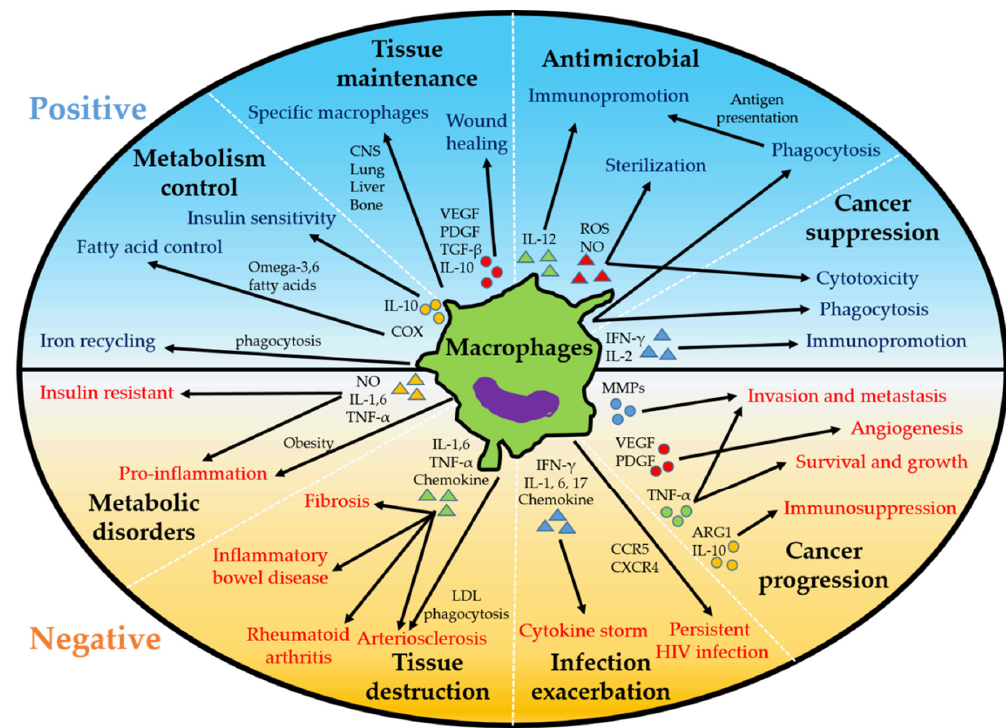
Figure 2. Positive and negative roles of macrophages. Macrophages exert antitumor effects but can act to promote tumor progression. Macrophages exert antimicrobial effects but can be targets of viruses and cause cytokine storms. Macrophages are responsible for tissue repair and metabolic control but can also cause tissue destruction and metabolic disturbances due to inflammation. IFN, interferon; IL, interleukin; ROS, reactive oxygen species; NO, nitric oxide; VEGF, vascular endothelial growth factor; PDGF, platelet ‐ derived growth factor; COX, cyclooxygenase; MMPs, matrix metalloprotease; TNF, tumor necrosis factor; ARG, arginase; CCR, CC chemokine receptor; CXCR, CXC chemokine receptor; LDL, low ‐ density lipoprotein.